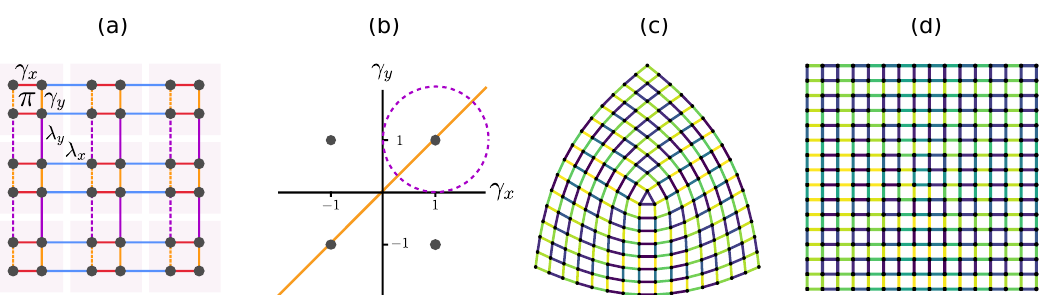
Figure 1: (a) The BBH model has four orbitals per unit cell, connected via γ x , y and λ hoppings. The dashed hopping lines have an extra phase of − 1 with re- x , y spect to the solid lines, threading a π flux through each plaquette. (b) The phase /λ | = 1 and diagram shows that the bulk gap closes at the grey dots, when | γ x x | γ /λ | = 1. The orange line indicates the set of parameters that preserve four-fold y y rotation symmetry and the dashed purple curve is a circular gapped path centered ) = ( 1,1 ) with radius γ = 1. (c) A disclination is created by effectively in ( γ , γ x y r removing one orbital from a unit cell. We expect both defects to host localized frac- tional charges. (d) A parametric defect is inserted in the BBH model using a gapped path in the phase diagram. The parametrization of the hoppings shifts the strongly bounded unit cells around the defect, creating a charge deficiency at it. The hopping strengths are given by the loop shown in